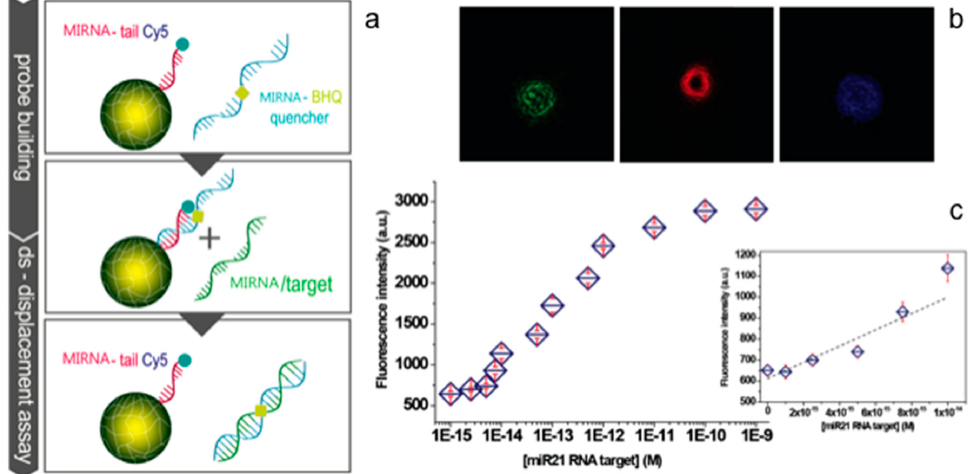
Figure 5. Microgel platform for microRNA detection based on a strande displacement mechanism: ( b ) the building of the probe on an encoded microgel; ( a ) the strand displacement upon contact with target microRNA and fluorescence recovery on the particles; and ( c ) the distinct fluorescent channels for fluorescein and rhodamine for the encoding and Cy5 for the detection of binding; in the lower part is reported the titration curve of the recovered fluorescence in response to increasing amounts of microRNA (the inset show the limit of detection (LOD) = 2.6 fM) (adapted with permission from [38]. Copyright 2015 American Chemical Society).